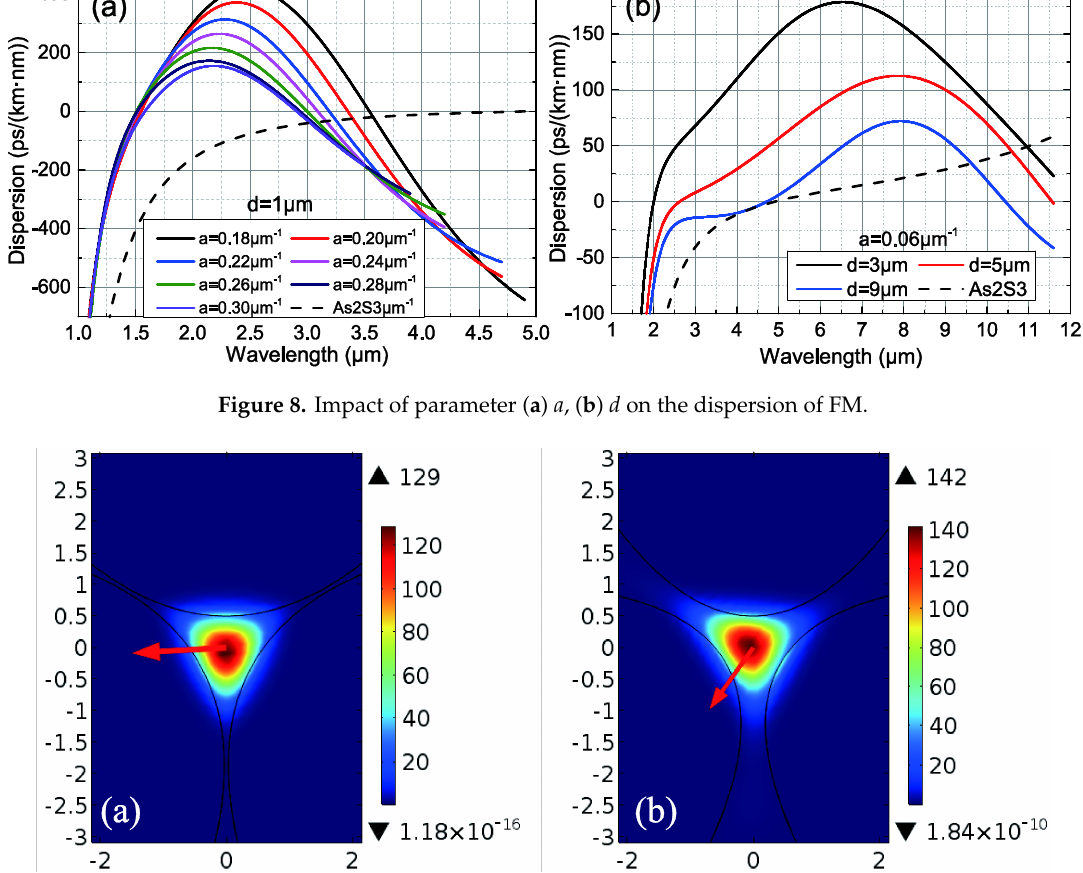
Figure 9. Electric field distribution of FM at λ = 1.5 µ m for SCFs with d = 1 µ m and ( a ) a = 0.18 µ m − 1 , ( b ) a = 0.3 µ m − 1 .